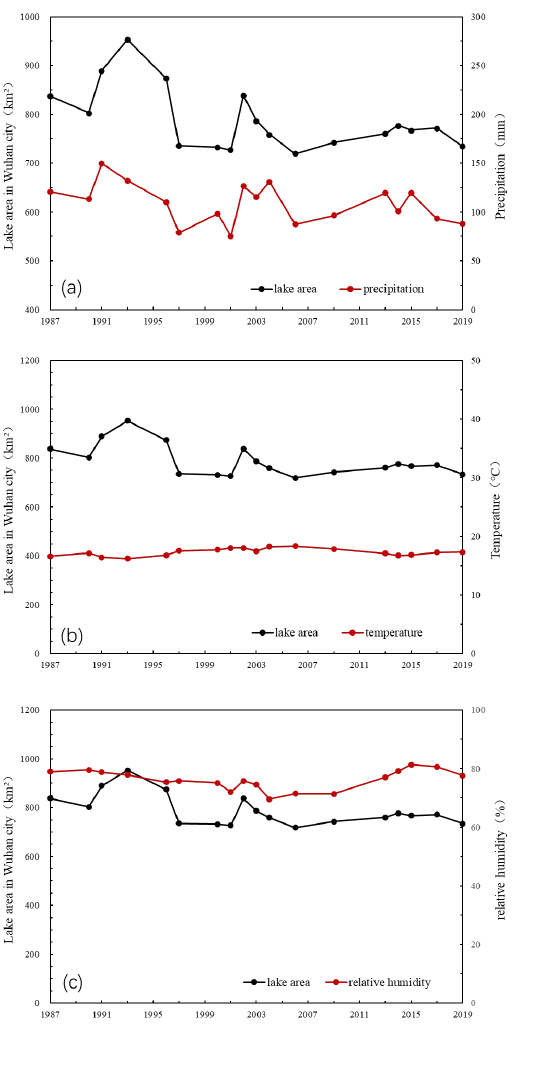
Figure 5 . (a) Correlation between precipitation and lake area (r=0.73); (b) Correlation between temperature and lake area (r=- 0.70); (c) Correlation between relative humidity and lake